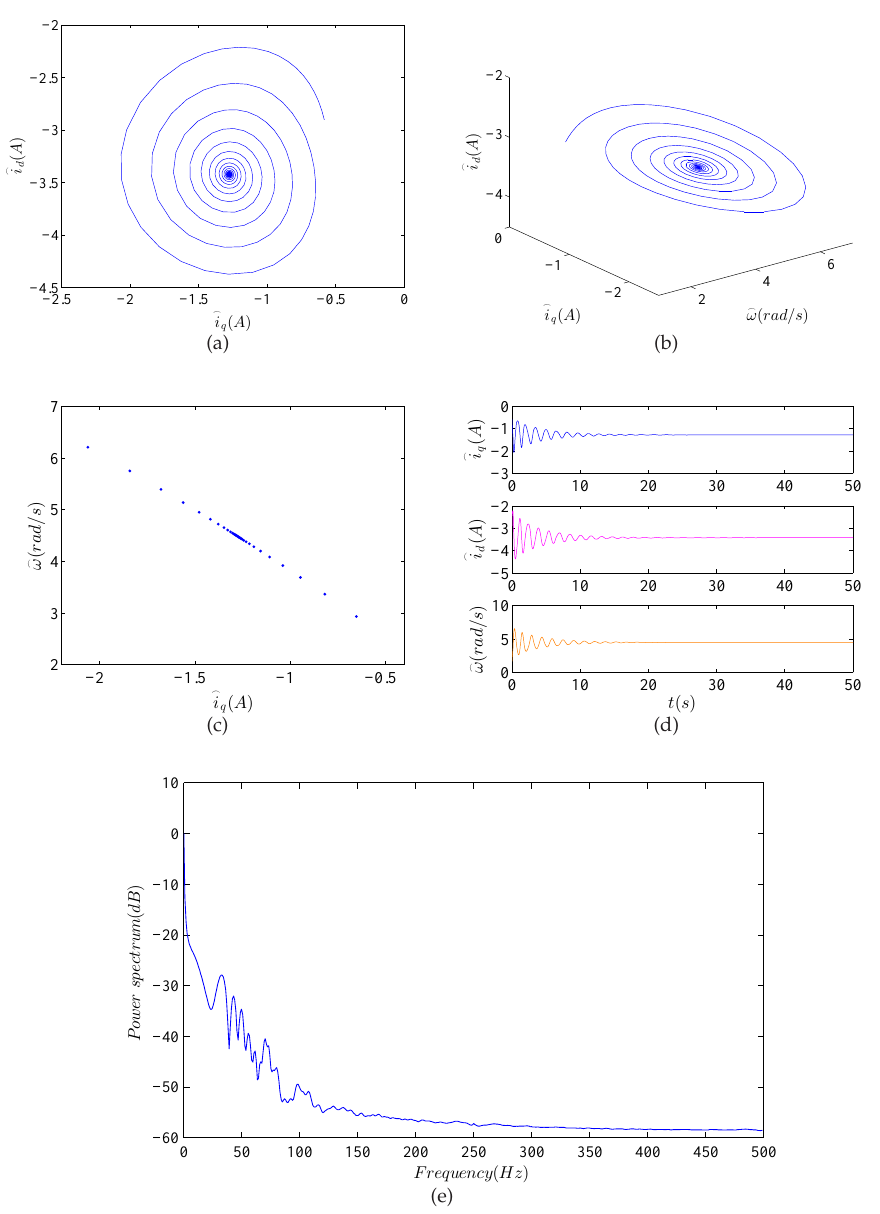
Figure 4. Numerical analysis of nonlinear dynamic behavior with ψ f = 3.9: ( a ) Phase orbit with ⌢ ⌢ i q − i d ; ( b ) Phase orbit with ⌢ ω −